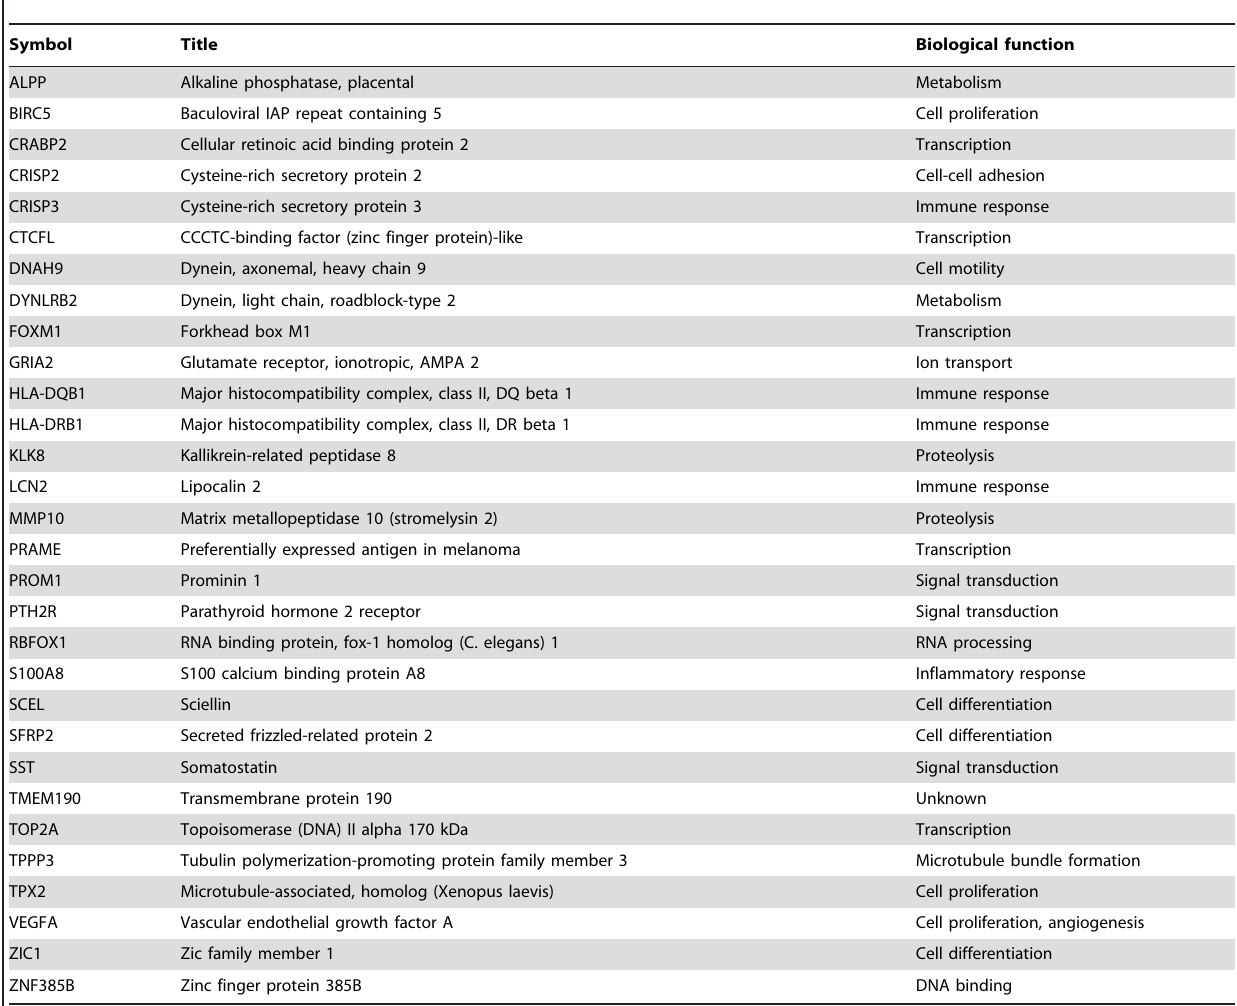
Table 3. Differentially expressed mRNAs selected for RT-qPCR